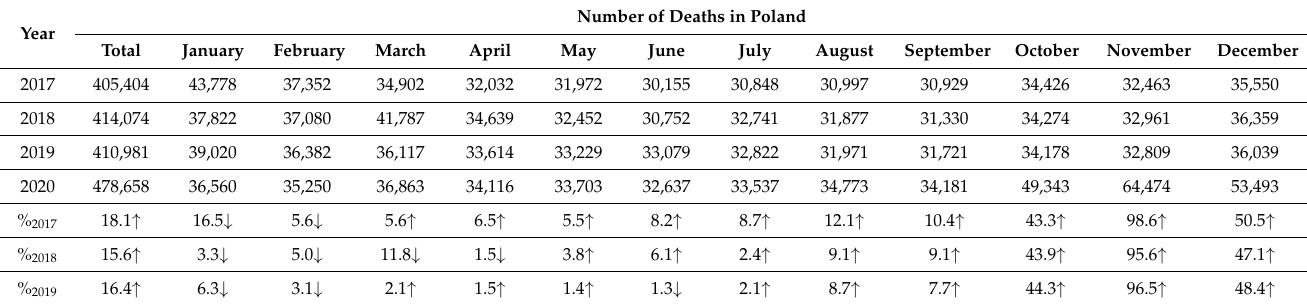
Table 2. Yearly and monthly number of total death registered between 2017 and 2020 in Poland.